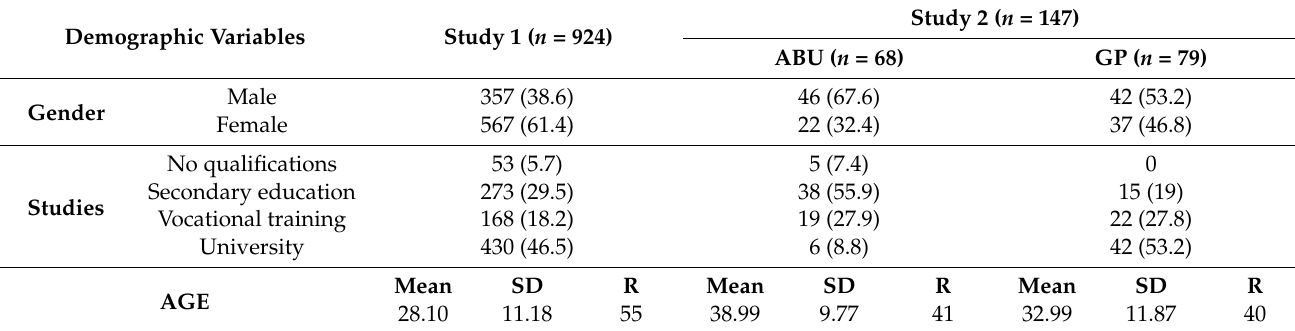
Table 1. Gender, age, and level of education of the participants in this study ( n =